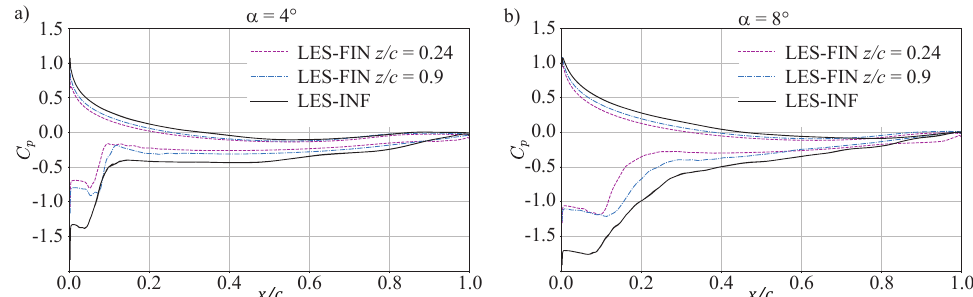
Figure 7. Comparison of infinite blade (LES-INF) and finite blade (LES-FIN) time-averaged pressure profiles at two spanwise positions for: ( a ) α 0 = 4 ◦ and ( b ) α 0 = 8 ◦